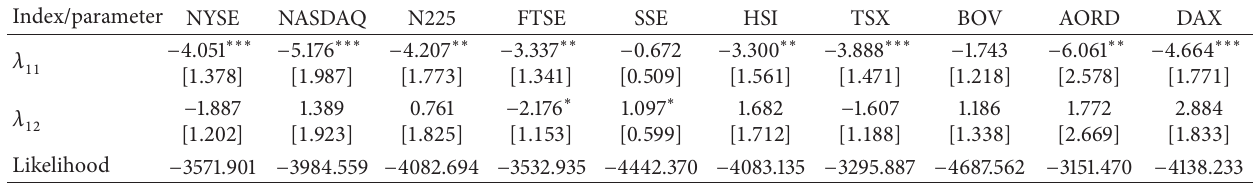
Table 13: Results of TVRAS-GARCH-M model